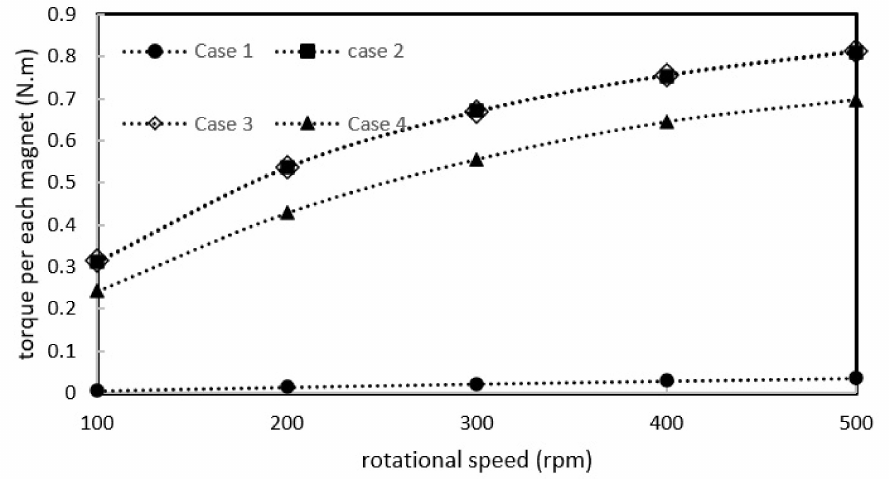
Figure 12. Torque per number of magnets at different rotational speeds.